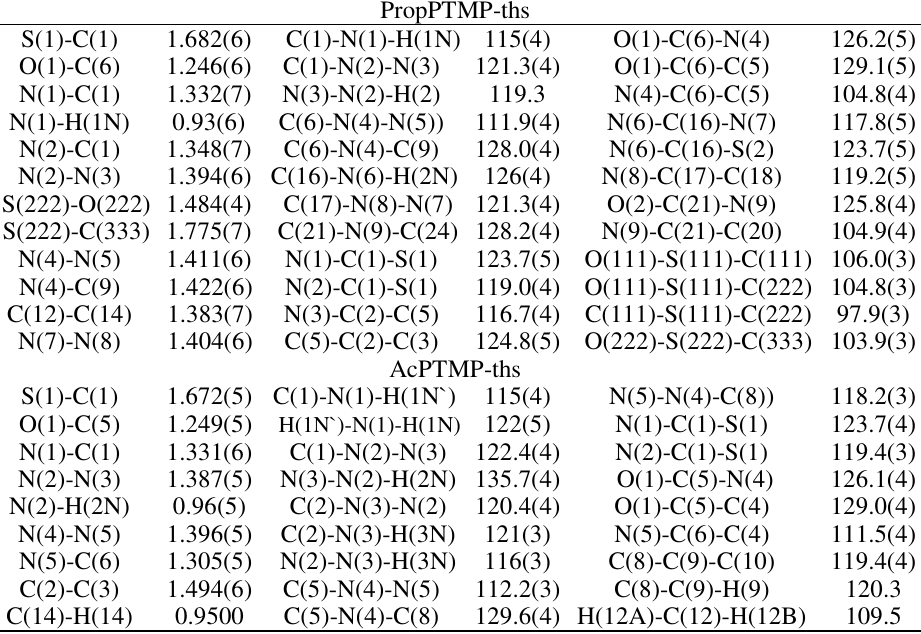
Table 2. Selected bond lengths and bond distances for complexes PropPTMP-ths & AcPTMP-ths